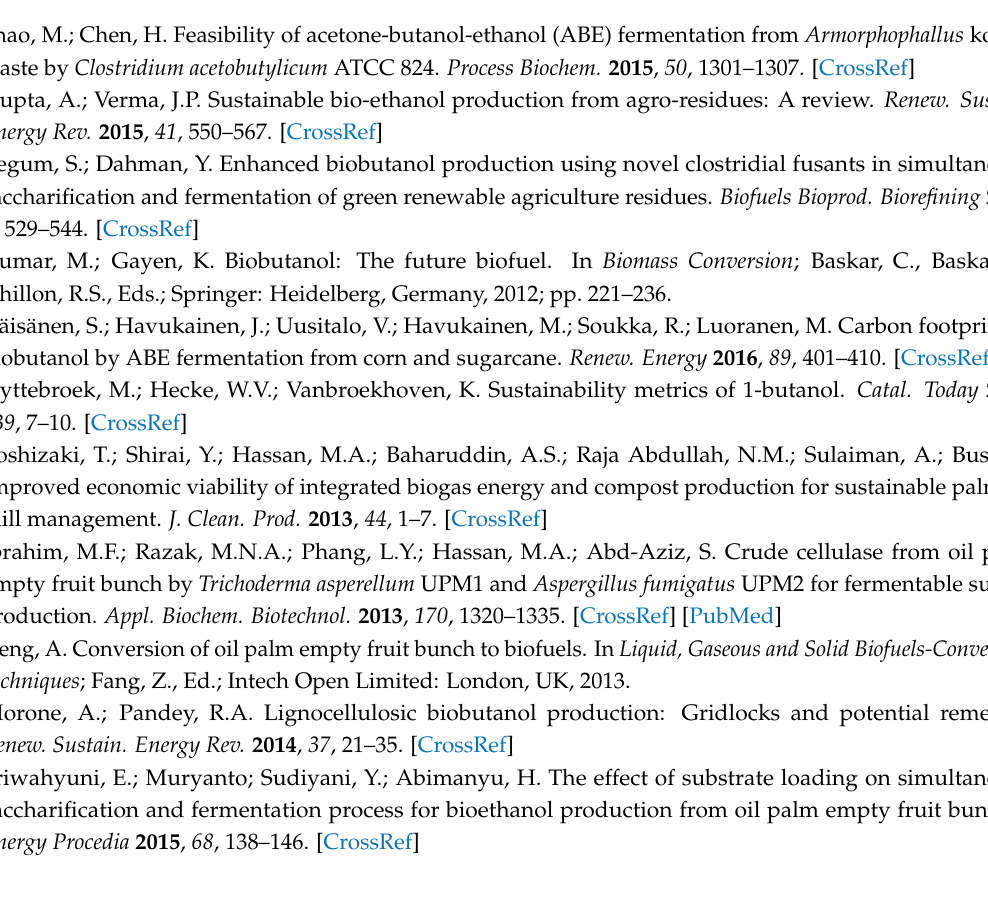
s1, Table S1: Coded values for each factor of the central composite design (CCD) for biobutanol production in SSF, Table S2: Experimental data of central composite design (CCD) for biobutanol yield, Table S3: The ANOVA for the second order model of central composite design (CCD) for biobutanol